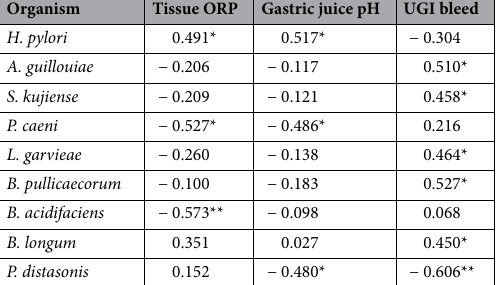
Organism Tissue ORP Gastric juice pH UGI